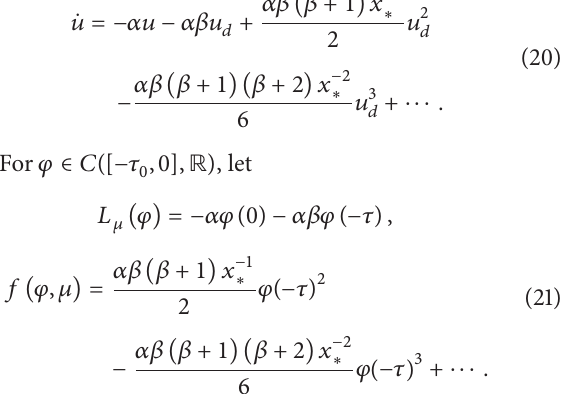
Figure 1: Stability and instability regions in (𝛽,𝜏) space are depicted in green and blue, respectively. According to Theorem 5, on the left of the dotted line the equilibrium is locally asymptotically stable for any 𝜏 . Parameter set: 𝛼 = 0.4 , 𝑐 = 0.77 , 𝑛 = 1 , and 𝑏 = 0.3